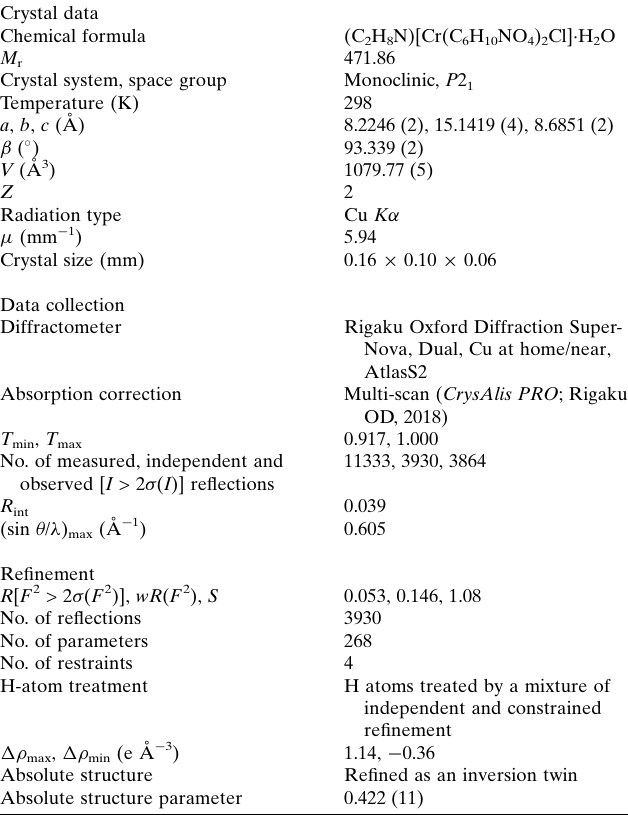
Table 2 Experimental details. Crystal data Chemical